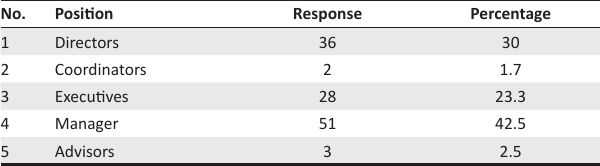
TABLE 1a: Demographic profile of respondents (Section A).